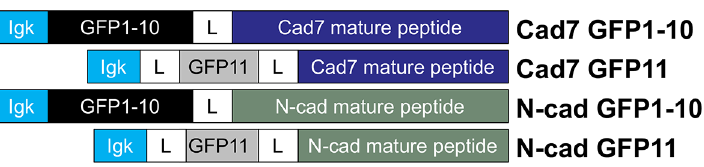
Figure 2. Cadherin-expressing GRASP constructs. Cartoon diagram showing GFP-cadherin fusion proteins that were constructed by joining the kappa light chain to distinct GFP subunits (1 – 10, or 11), followed by a linker region and then the mature cadherin peptide. GFP, green fluorescent protein; GRASP, GFP reconstitution across synaptic partners; N-cad, neural cadherin; Cad7,